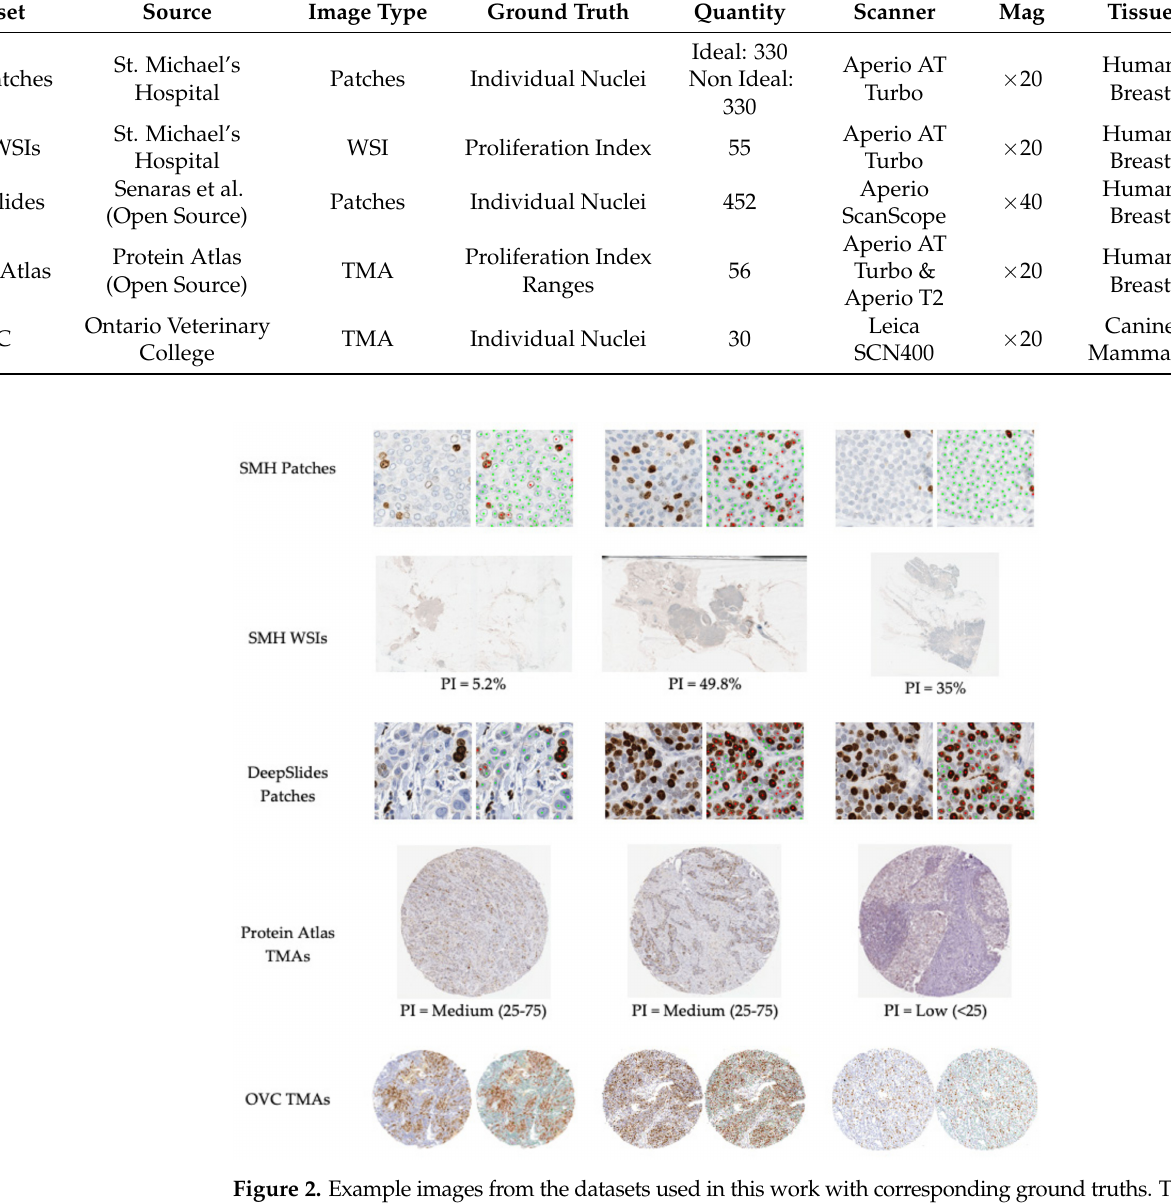
Figure 2. Example images from the datasets used in this work with corresponding ground truths. There is clear variability in the types of images, staining concentrations and color variability in the